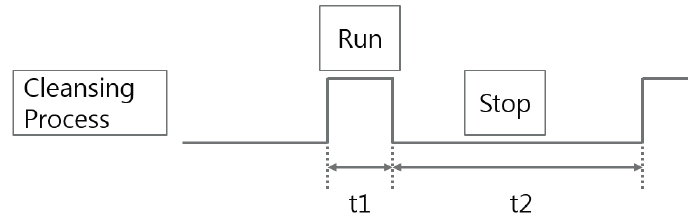
Figure 5. Flow chart for the auto clarifier